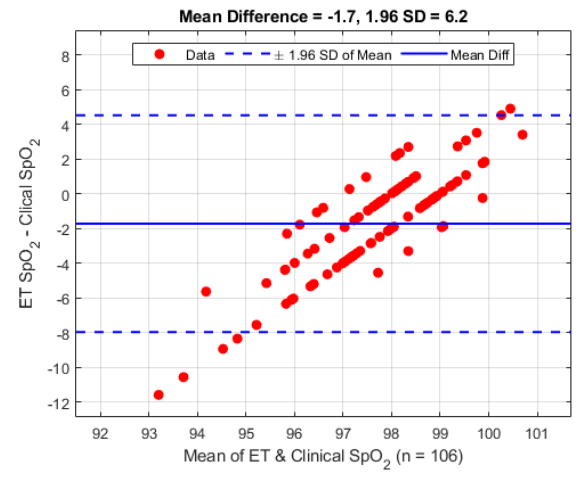
Figure 8. Bland–Altman analysis of SpO 2 from the ET sensor vs. the clinical monitor.